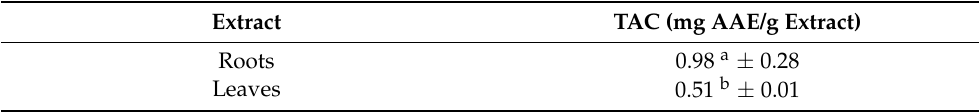
Table 3. Total antioxidant capacity of the two extracts of A. italica Retz.